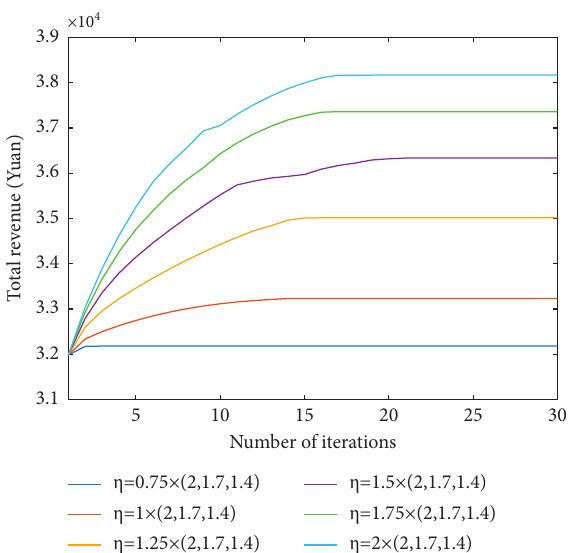
Figure 6: The total revenue changing with five groups of price elasticity parameters.